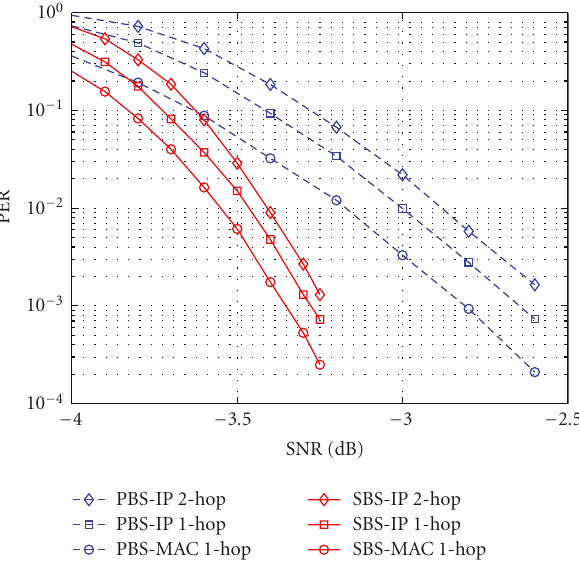
Figure 8: PBS and SBS performance comparison with IR-HARQ, for N = 3, P = 8, and C = 24.